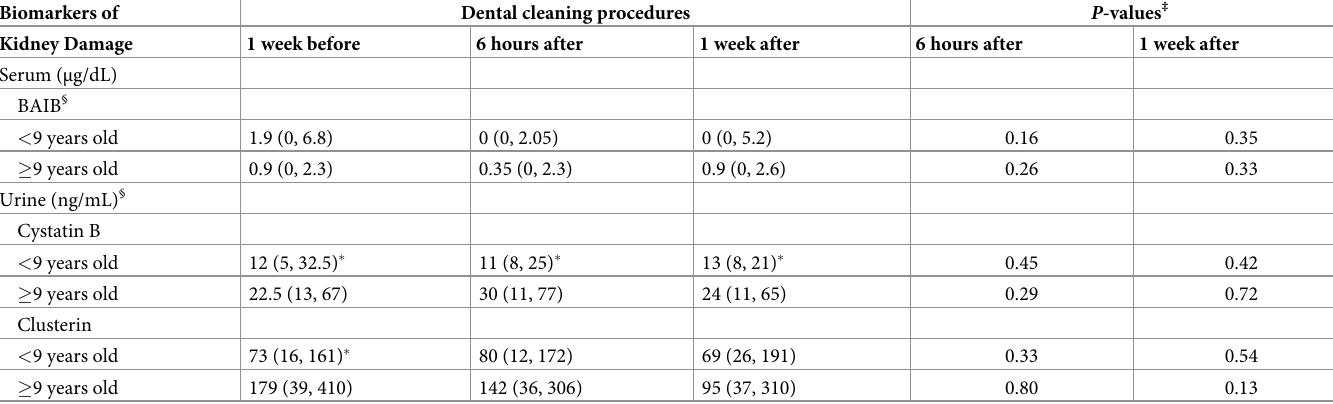
Table 7. Serum and urine kidney tissue damage biomarkers before and after general anesthesia and dental cleaning procedures in cats and dogs with periodontal disease stratified by age (n = 62) � . Biomarkers of Dental cleaning procedures